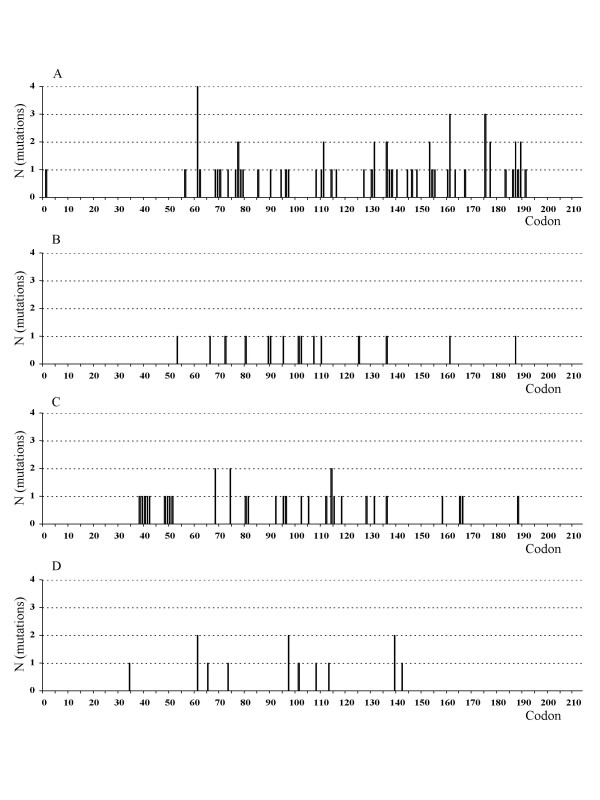
Type of mutation plotted against the codon number. A. Truncating mutations (Frameshift & Nonsense mutations) B. In-frame insertions/deletions C. Missense mutations D. Silent mutations Codon 1–114 encodes exon 1, codon 114–155 encode exon 2, and codon 155–213 encode exon 3.